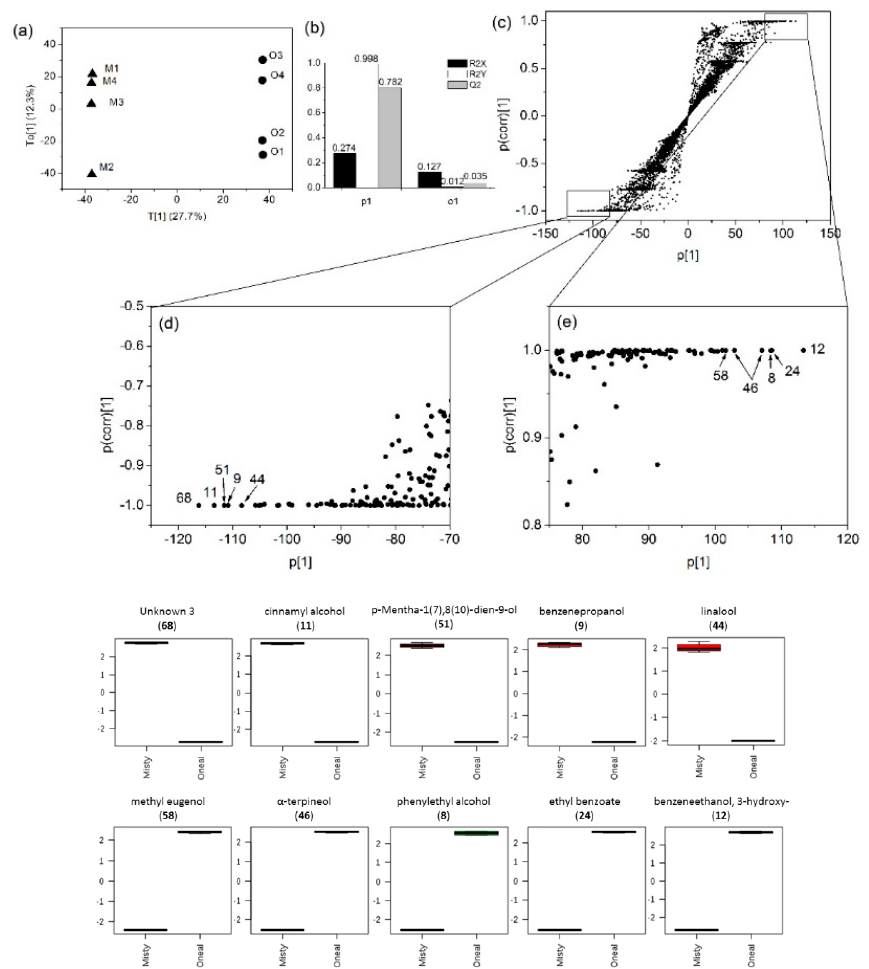
Figure 3. OPLS-DA of metabolite features detected in the blueberry wines by SPE-GC-QTOF-MS. ( a ) Score plot of all metabolite features; ( b ) Model overview of the OPLS-DA model; ( c – e ) Loadings S-plot showing the variable importance in a model, combining the covariance and the correlation (p(corr)) loading profile. The box-plots at bottom showed the significantly different volatile metabolites between Misty blueberry wine (M1, M2, M3, M4) and O’Neal blueberry wine (O1, O2, O3, O4) in the OPLS-DA model (Line, mean; box, standard error; whisker, standard